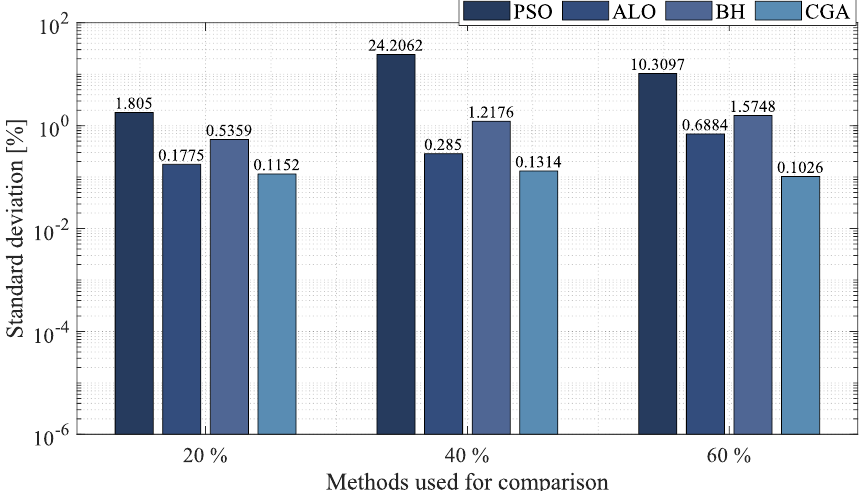
Figure 17. Percentage of standard deviation obtained by the MVO in the 10-node mesh test system compared to other